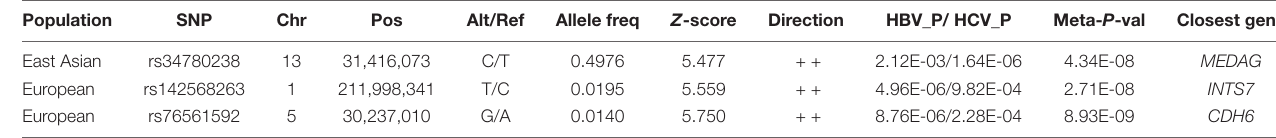
TABLE 1 | The novel significant associations with HBV/HCV infection.